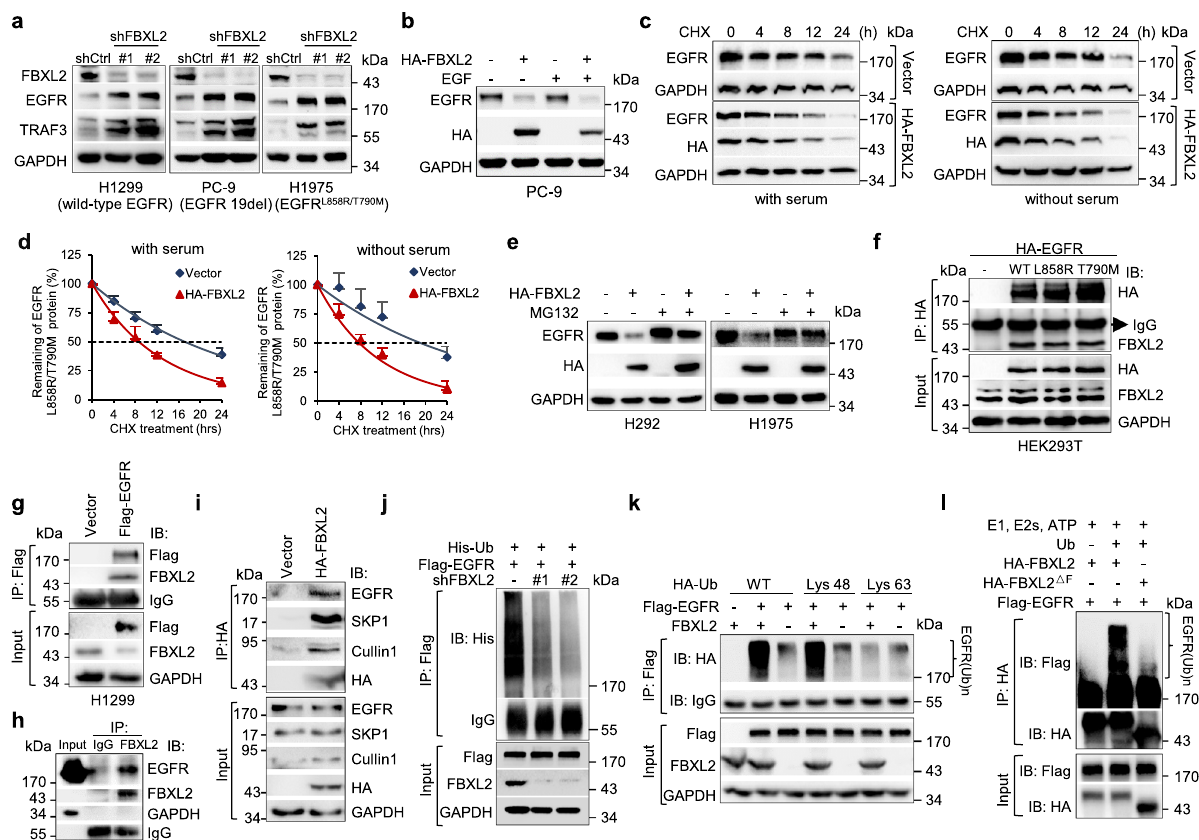
Fig. 1 FBXL2 targets EGFR for polyubiquitin- and proteasome-mediated degradation in an EGF-independent manner. a H1299, PC-9, or H1975 cells stably expressing different shRNAs against FBXL2 (shFBXL2-#1 or shFBXL2-#2) or GFP (shCtrl) were subjected to Western blot analyses. b PC-9 cells stably expressing HA-FBXL2 were grown in serum-free medium for 12 h, prior to treatment with or without 100 ng/mL EGF for 10 min. Cell lysates were subjected to Western blot analyses. c , d H1975 cells stably expressing HA-FBXL2 were grown in the absence or presence of serum (10%) for 12 h, prior to the treatment with 50 µ g/mL cycloheximide (CHX) for an indicated time interval. Cell lysates were subjected to Western blot analyses. Three independent experiments were performed. The EGFR protein levels were quanti fi ed and a plot representing protein half-life was presented as means ± SD. e H292 or H1975 cells stably expressing HA-FBXL2 were treated with MG132 for 6 h prior to Western blot analyses. f HEK293T cells were co-transfected with FBXL2 and an indicated EGFR expressing plasmids. Cells were grown overnight and treated with 20 µ M MG132 for 4 h, followed by IP (immunoprecipitation)- Western analyses. g H1299 cells stably expressing Flag-EGFR were treated with MG132 for 4 h before harvesting for IP-Western analyses. h H1975 cells were treated with MG132 for 4 h, and endogenous FBXL2 protein was immunoprecipitated with a speci fi c antibody for FBXL2 or normal rabbit IgG, followed by immunoblotting. i H1299 cells stably expressing HA-FBXL2 were treated with MG132 for 4 h before harvesting for IP-Western analyses. j HEK293T cells were co-transfected with indicated expressing plasmids. Cells were grown overnight and treated with MG132 for 4 h, followed by IP-Western analyses. k HEK293T cells were co-transfected with Flag-EGFR, FBXL2, and either HA-ubiquitin wild-type, Lys 48-only, or Lys 63-only expressing plasmids. Cells were grown overnight and treated with MG132 for 4 h, followed by IP-Western analyses. l In vitro ubiquitination reaction mixtures were subjected to immunoblotting with either antibody speci fi c for Flag or HA. The experiment was repeated three times independently with similar results ( a , b , e – l ). Source data are provided as a Source data fi